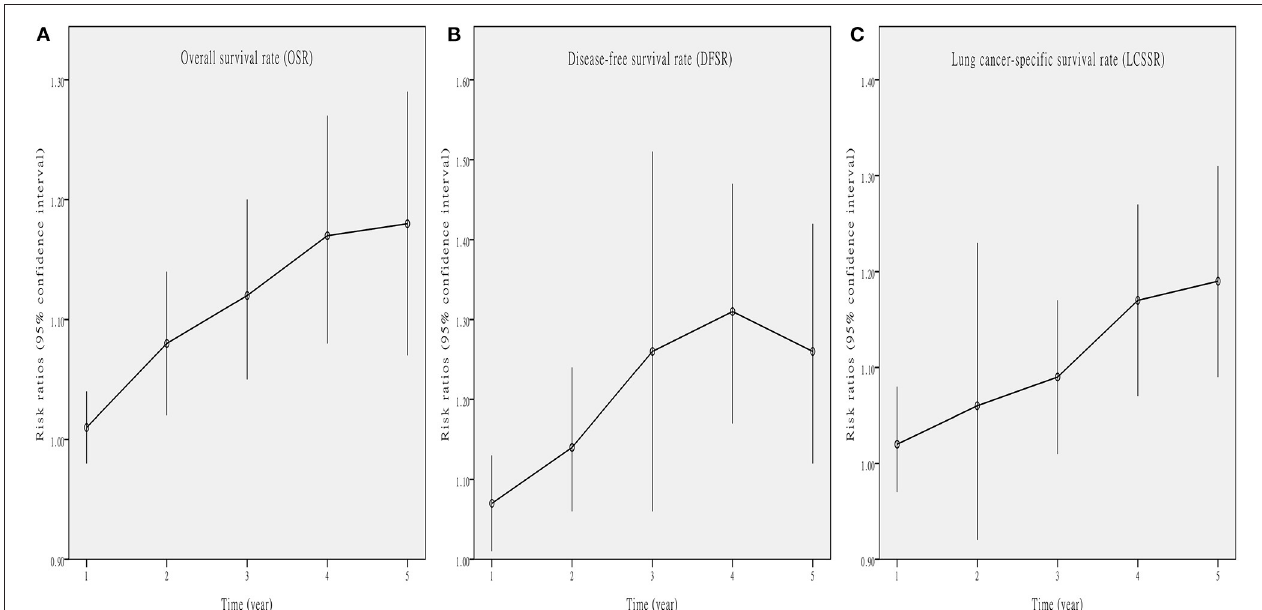
FIGURE 4 | Line charts of OSR (1–5 years, A ), DFSR (1–5 years, B ), and LCSSR (1–5 years, C ) associated with Vein-first vs. Artery-first according to survival time.